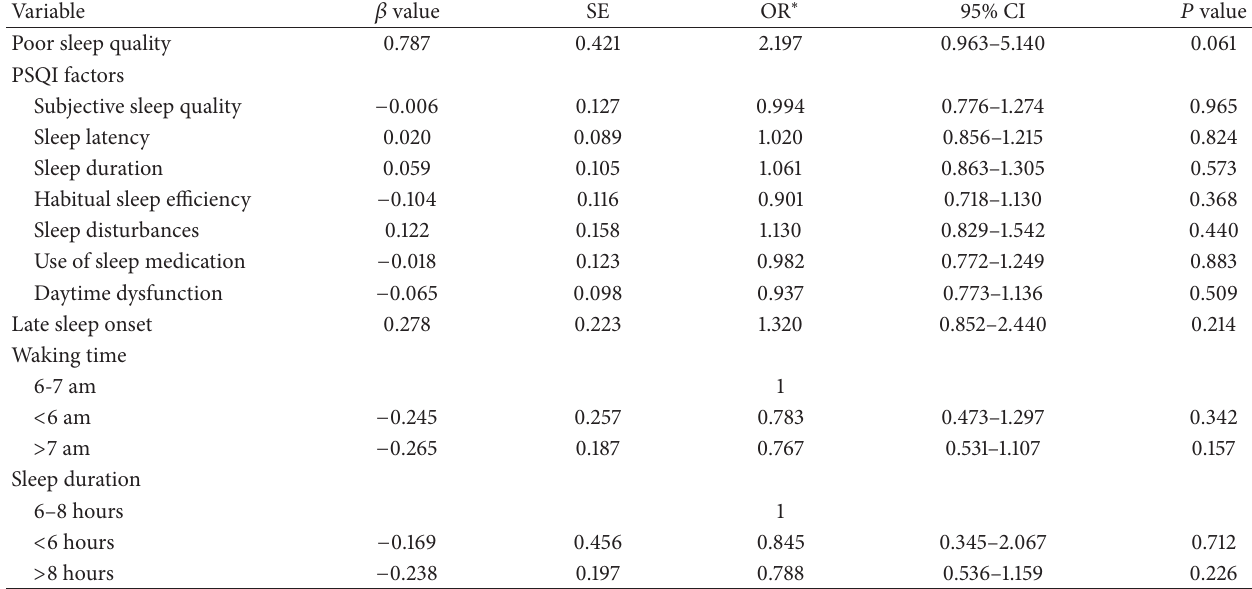
Table 3: Logistic regression analysis of the relationship between “sleep” and